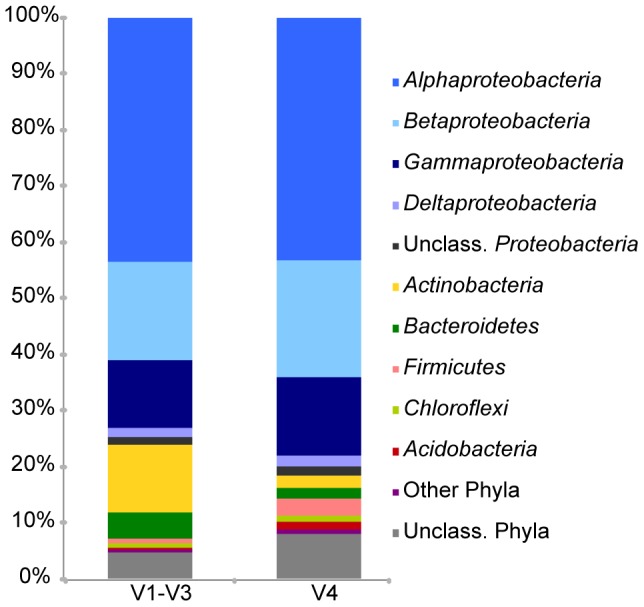
Distribution of bacterial phyla and classes of Proteobacteria according to the 16S rRNA gene region.Data of each 16S rRNA region correspond to the average of 12 duplicate monthly samples. Sequences were classified against RDP database at a confidence threshold of 80%. Phyla with average percentage of abundances lower than 1% were included in “other Phyla” (Spirochaetes, Armatimonadetes, Epsilonproteobacteria, SR1, Deinococcus-Thermus, Synergistetes, Fusobacteria, Verrucomicrobia, Gemmatimonadetes, TM7 and Planctomycetes).